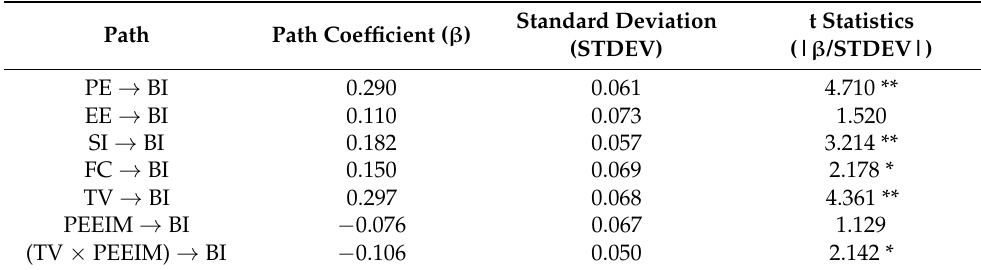
Table 9. Structural model assessment with inclusion of PEEIM as the moderator.